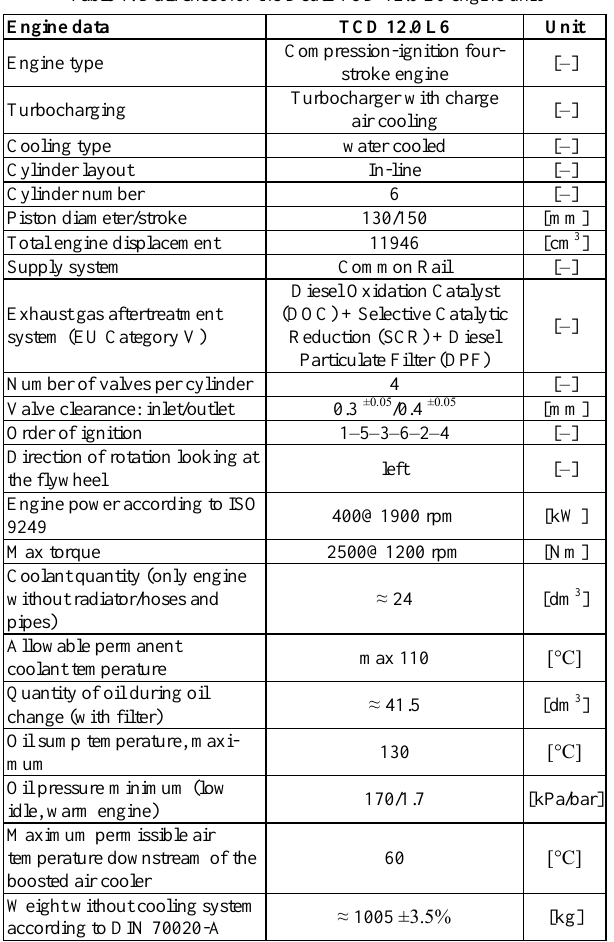
Table 1. Data sheet for the Deutz TCD 12.0 L6 engine unit